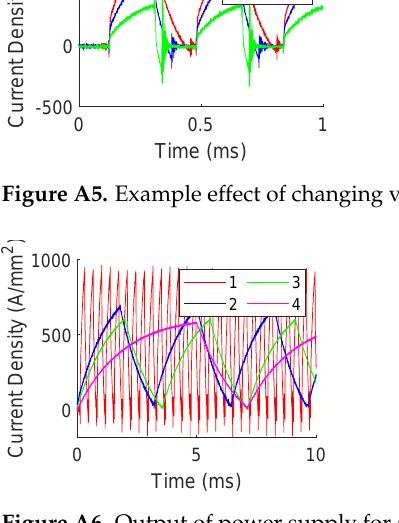
Figure A6. Output of power supply for all test IDs; 36 V.